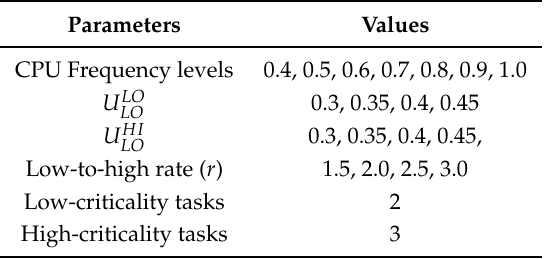
Table 4. Simulation